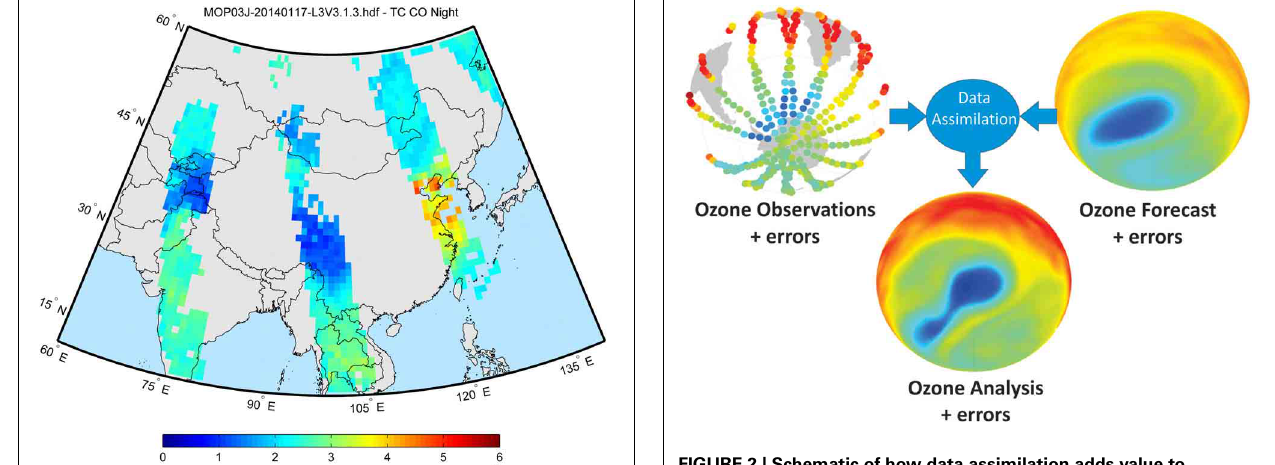
FIGURE 2 | Schematic of how data assimilation adds value to observational and model information. The data shown are various representations of the ozone distribution at 10hPa ( ∼ 30km) on 23 September 2002, each of which has errors. Upper left panel: plot representing ozone data from a limb-viewing satellite. Upper right panel: plot representing a 6-day ozone forecast based on output from a data assimilation system. Bottom panel: plot representing an ozone analysis based on output from a data assimilation system. Blue colors represent relatively low ozone values; red/orange colors represent relatively high ozone values. The analysis is produced by combination of the observational and model information and their errors. Note how the analysis fills in the observational data gaps and captures the Antarctic ozone split, verified using independent data not used in the assimilation. By contrast, the ozone hole split is not captured in the 6-day ozone forecast. Based on material in Lahoz et al.